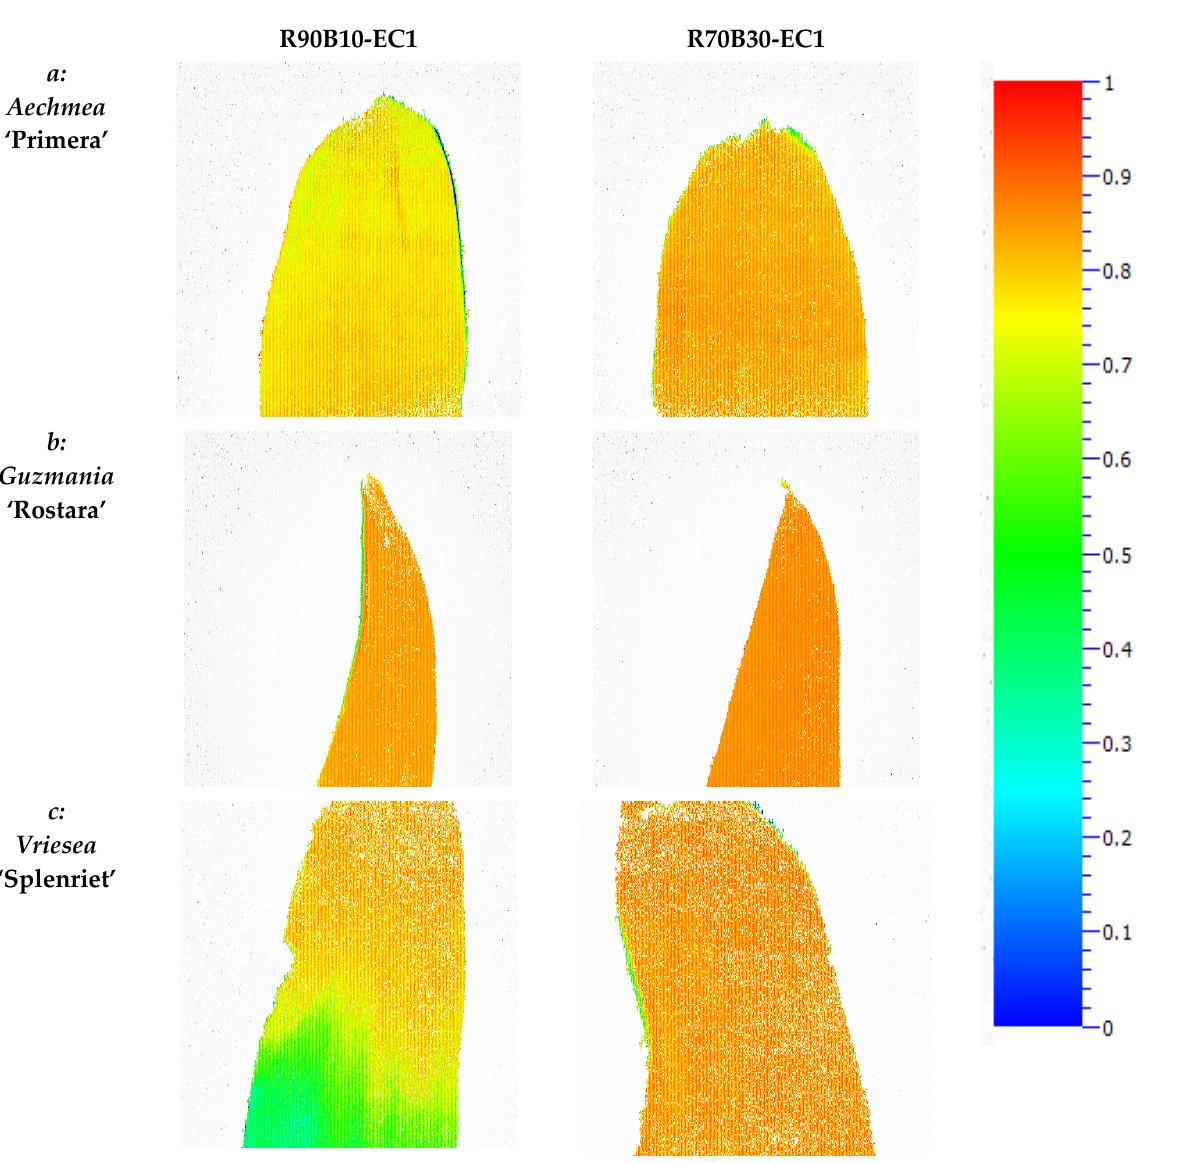
Figure 5. Representative images of maximum quantum efficiency of PSII in the three species under study cultivated under supplementary light of R90B10 [90% red (R) and 10% blue (B)] or R70B30 (70% R and 30% B) and nutrient solution electrical conductivity of 1 dS m − l (EC1).